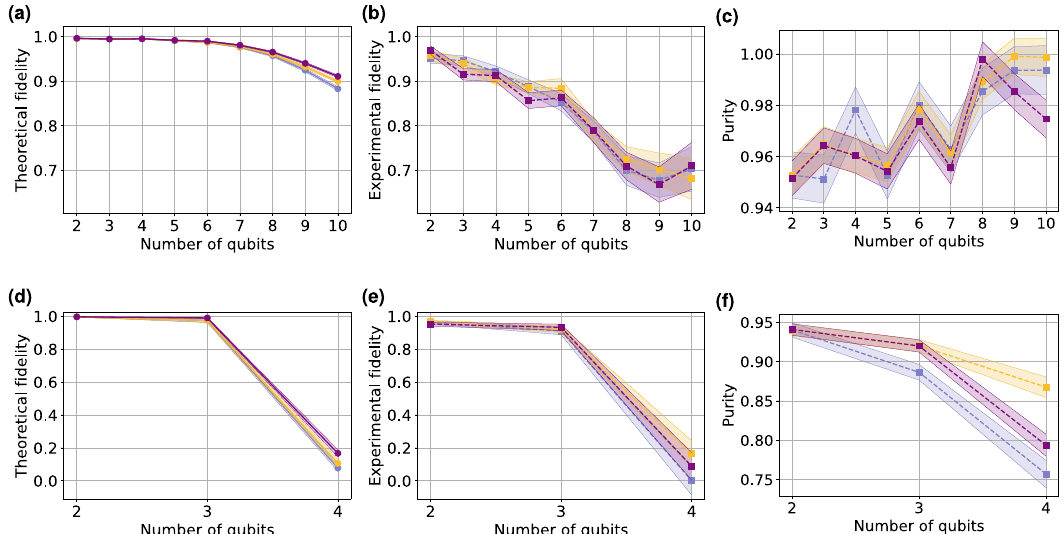
(cid:2) (cid:4) (cid:2) as a function of the number of qubits. a Theoretical 2